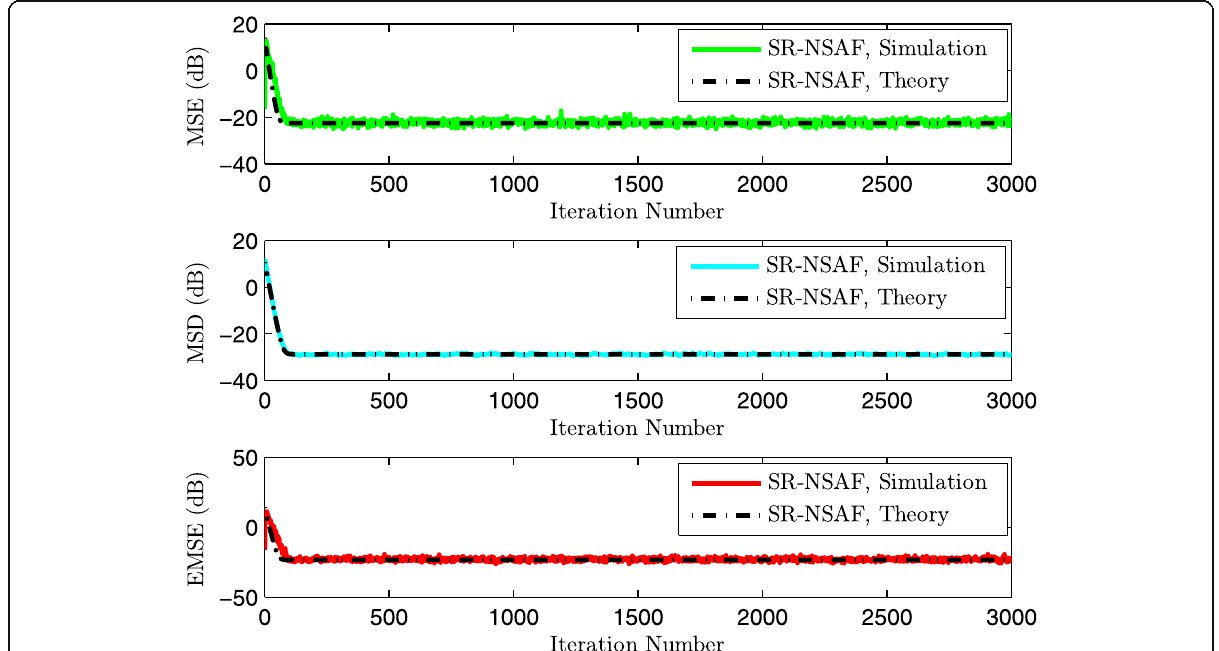
Fig. 23 Simulated and theoretical MSE, MSD and EMSE learning curves of SR-NSAF with N = 4 and μ =